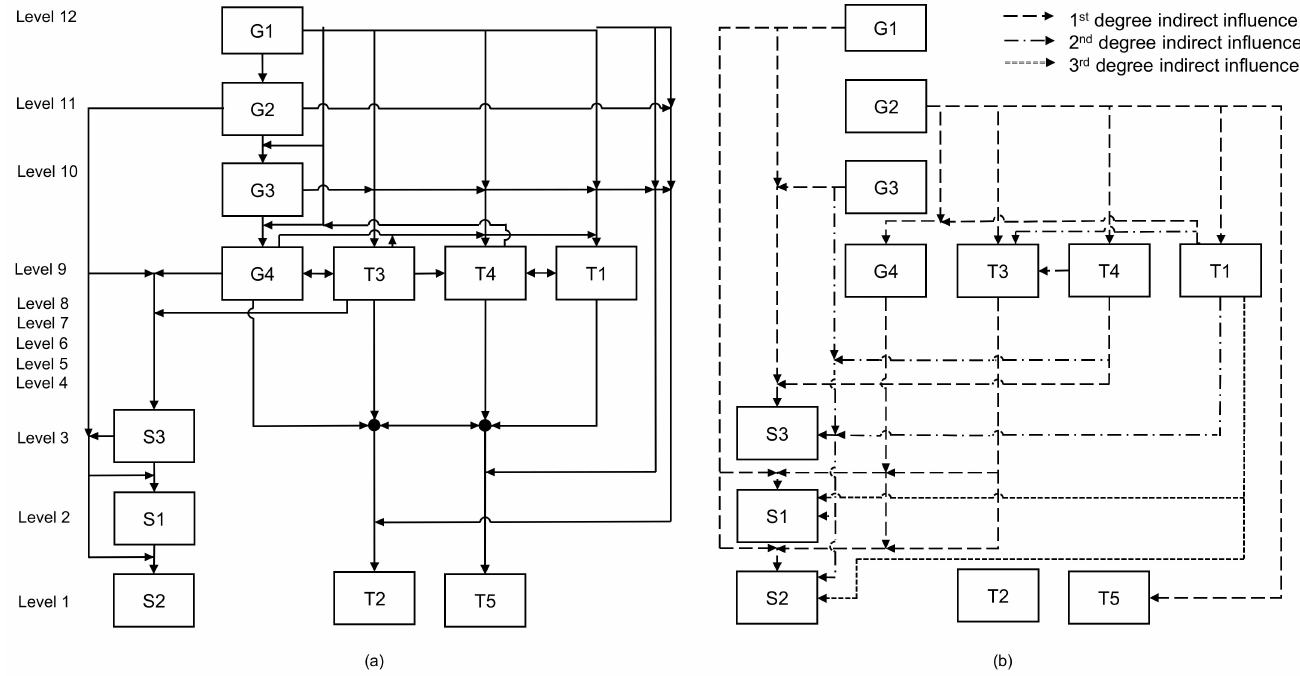
Figure 2. ISM diagram for the ( a ) direct and ( b ) indirect influence interrelationships between the barriers to IFRM adaptation in Metro